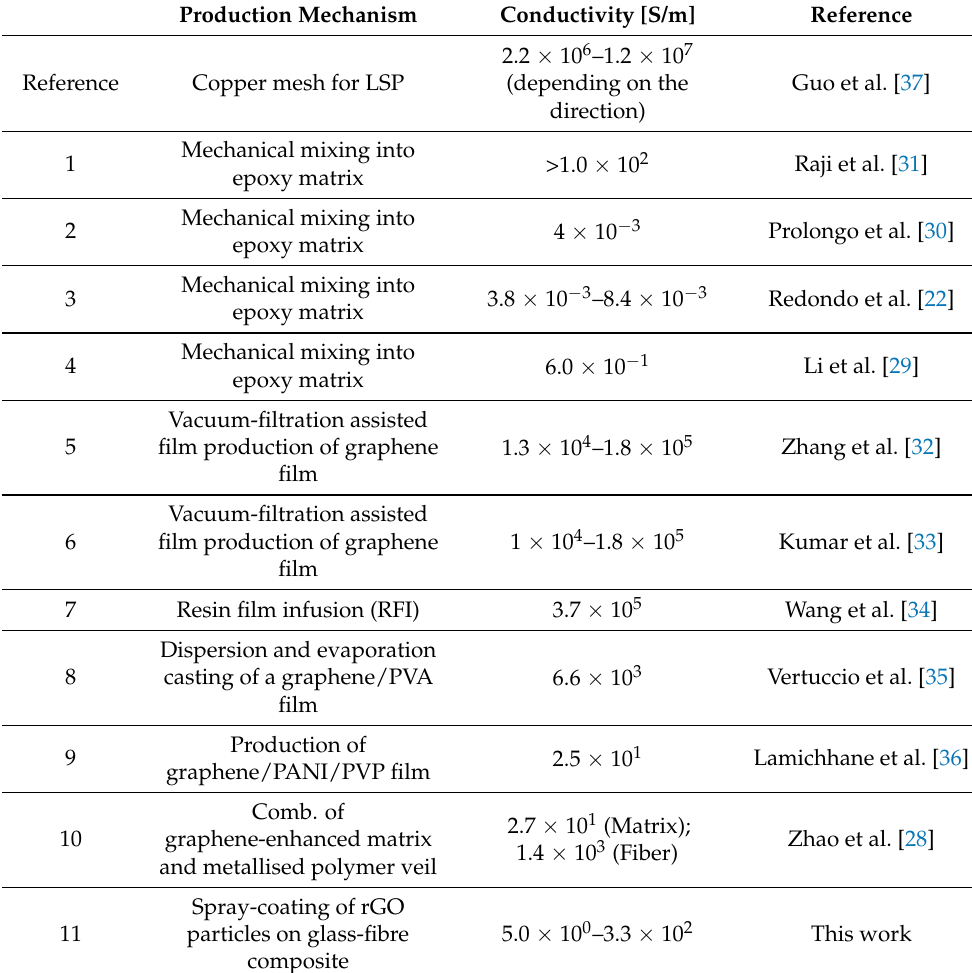
Table 1. Conductivity of various graphene-based composites compared to a copper